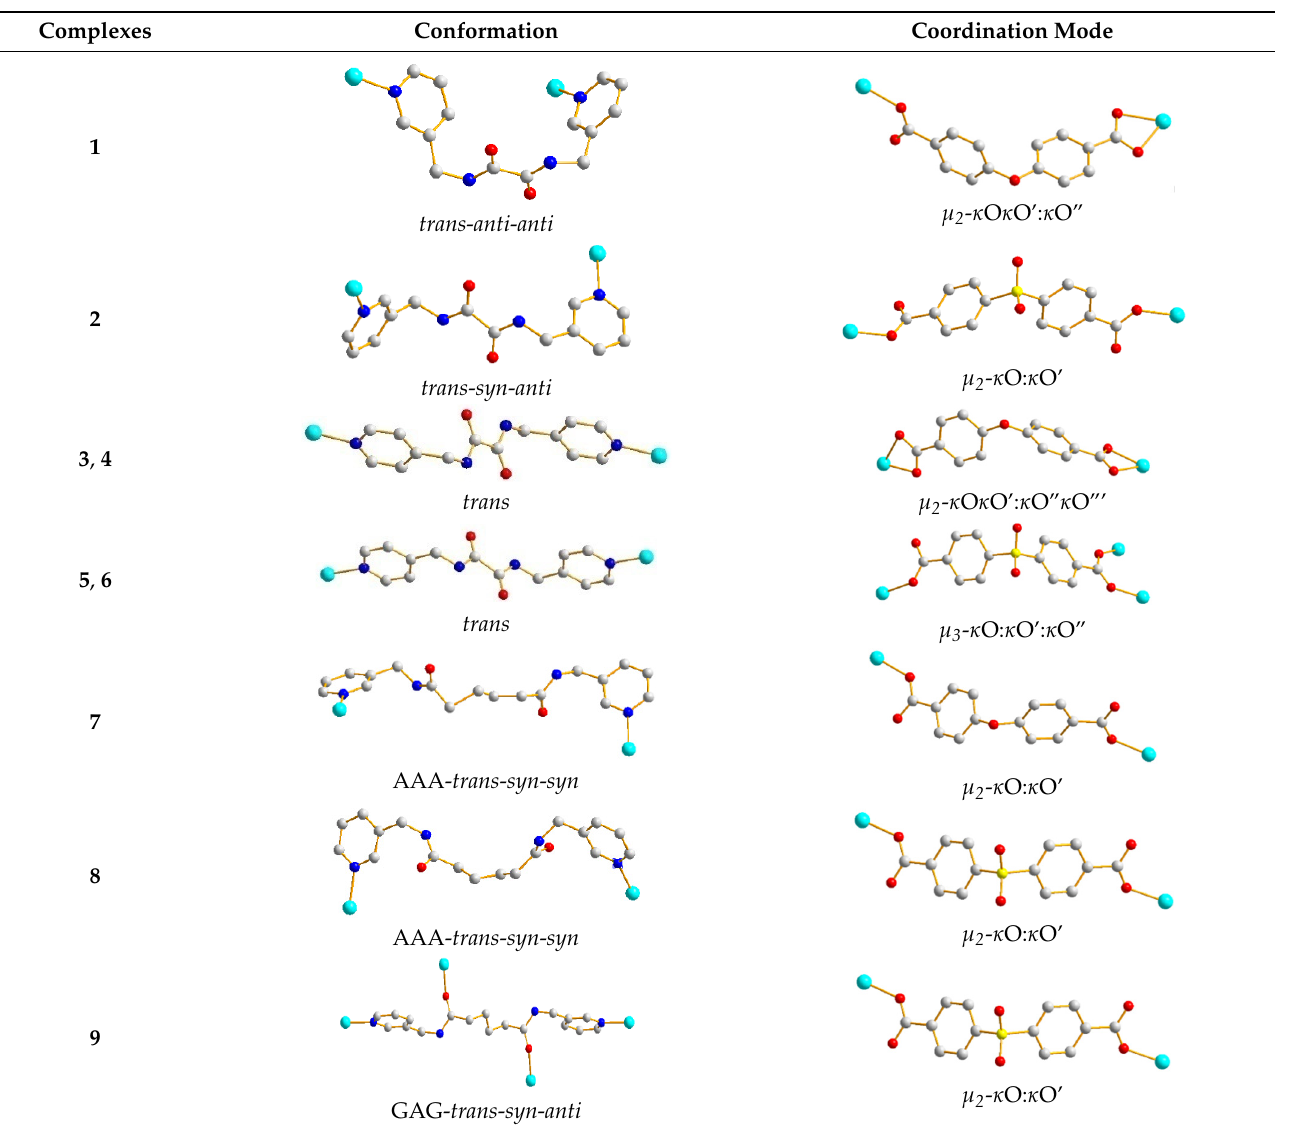
Table 1. Ligand conformations and bonding modes of 1 – 9 .